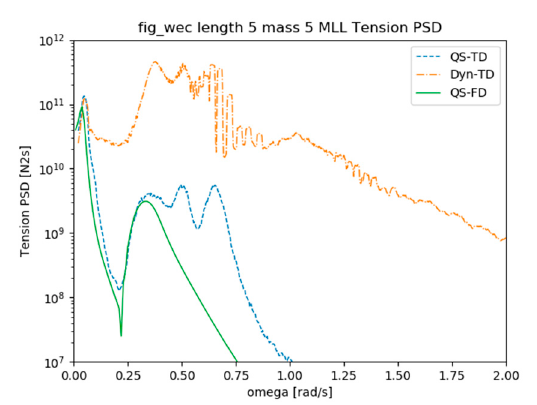
Figure 11. Most loaded line tension factors for the FWEC with the QSTD ( a ) and DynTD ( b ) models.